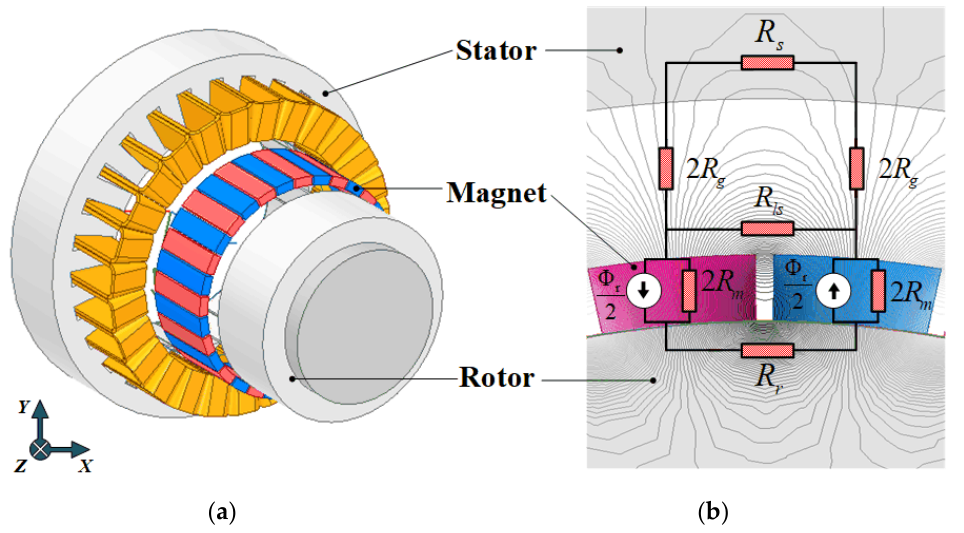
Figure 1. Structures of PMSM: ( a ) 3D FEM and ( b ) magnetic equivalent circuit considering only half of each pole.